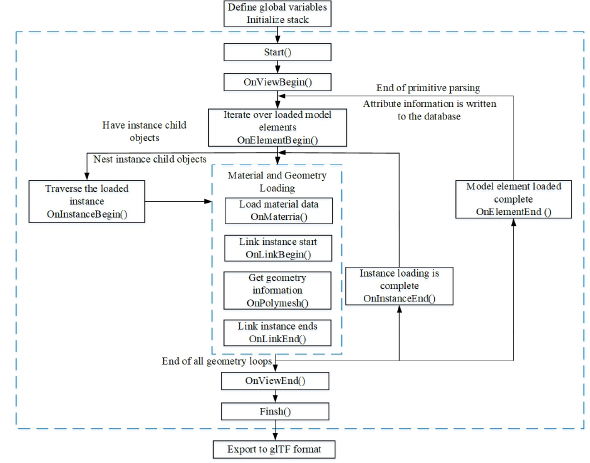
Fig. 3. Process of model data